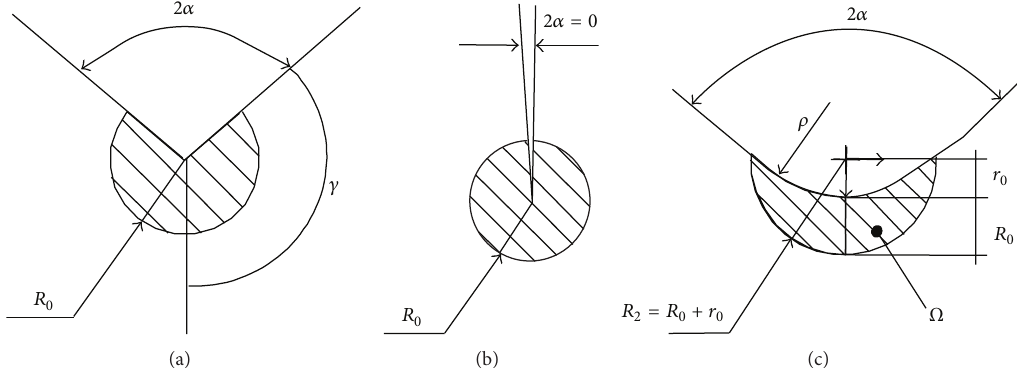
Figure 6: Critical volume (area) for sharp V-notch (a), crack (b), and blunt V-notch (c) under mode I loading. Distance 𝑟 0 = 𝜌×(𝜋−2𝛼)/(2𝜋− 2𝛼) .